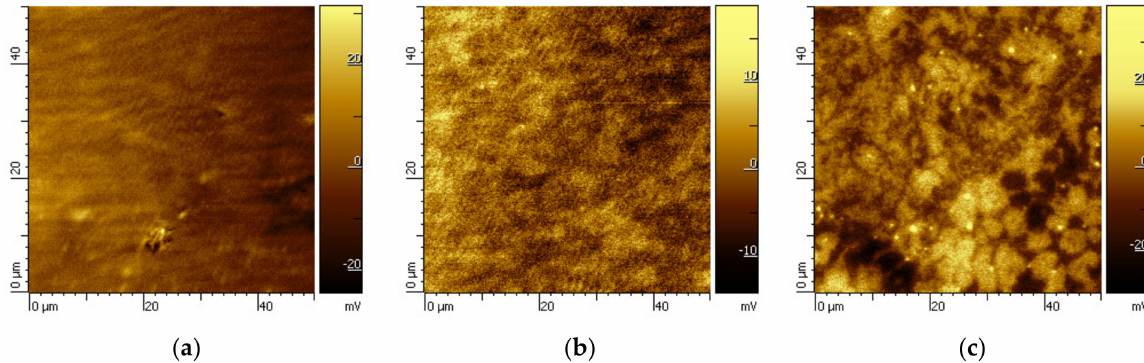
Figure 7. AFM-SKP maps of the surface of the polished Mn-based alloys: ( a ) 0% Al, ( b ) 10% Al, and ( c ) 20%